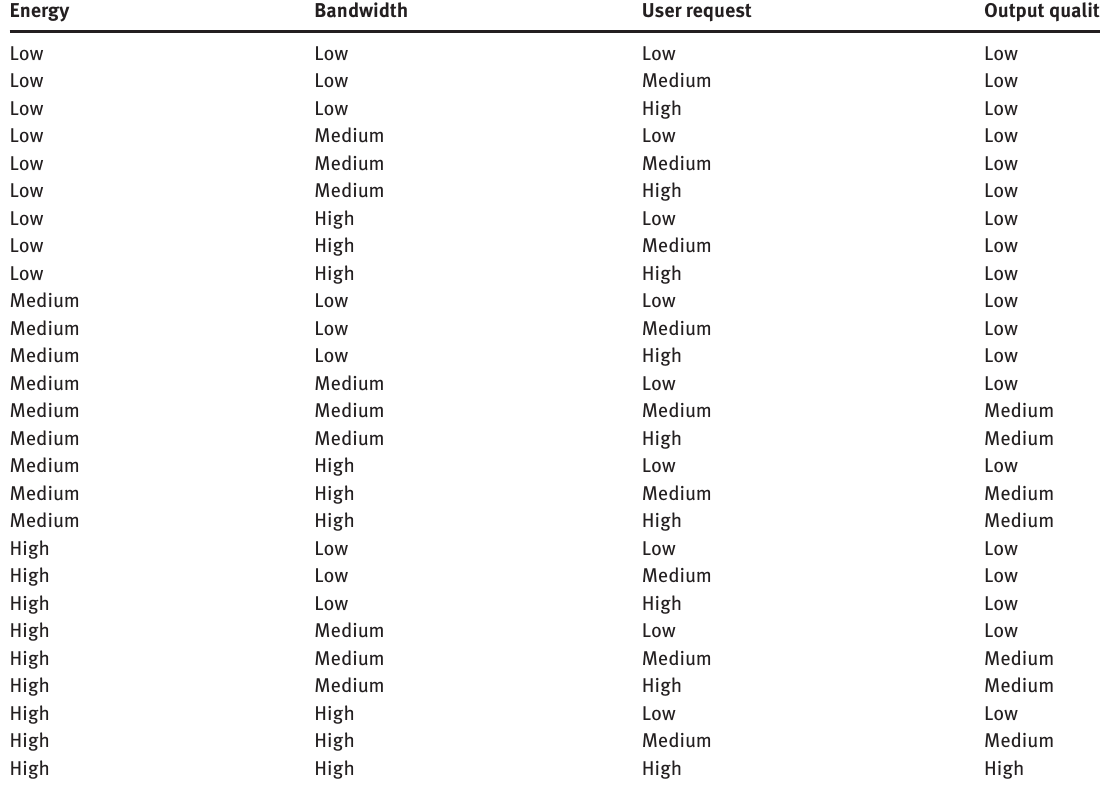
Table 1: Resource Mapping